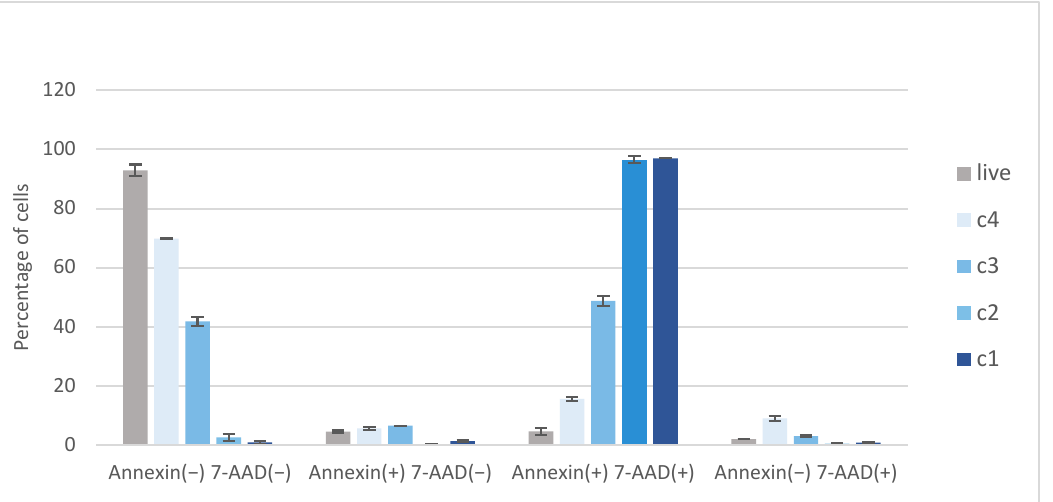
Figure 6. Cell distribution; effect of hemp (EC) extract on activation of apoptosis in WM − 266 − 4 cells ( c 1 = 3 × 10 − 3 mg/mL, c 2 = 2 × 10 − 3 mg/mL, c 3 = 10 − 3 mg/mL, c 4 = 7 × 10 − 4 mg/mL).